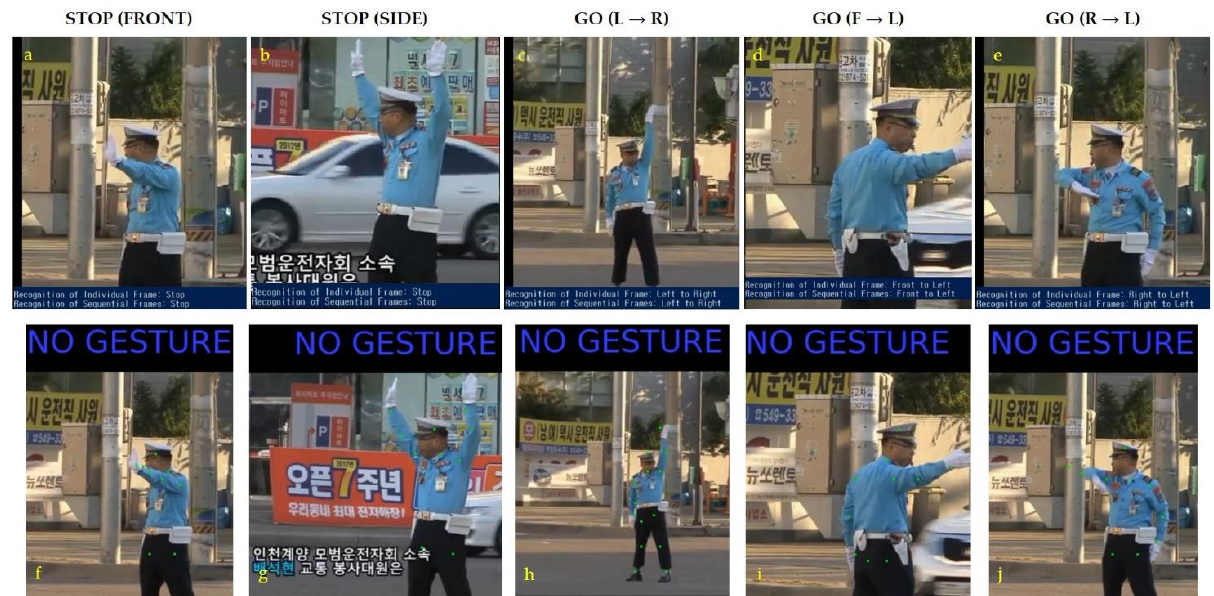
Figure 13. Performance comparison of the traffic gesture recognition for different traffic gestures. Here, ( a – e ) represent gesture detection by our proposed approach, and ( f – j ) represent the corresponding detections through the CPM approach.